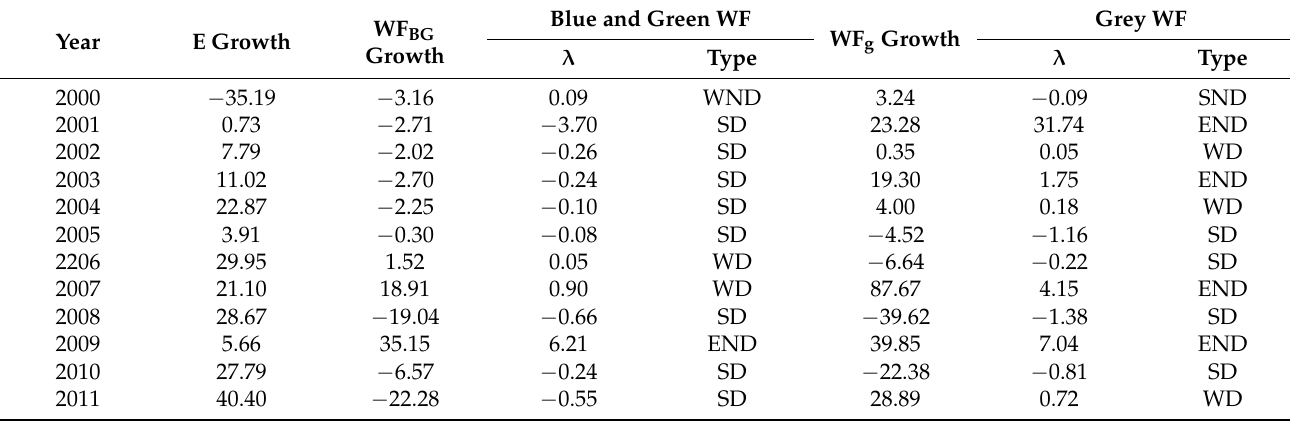
Table 2. Decoupling Relationship between E and